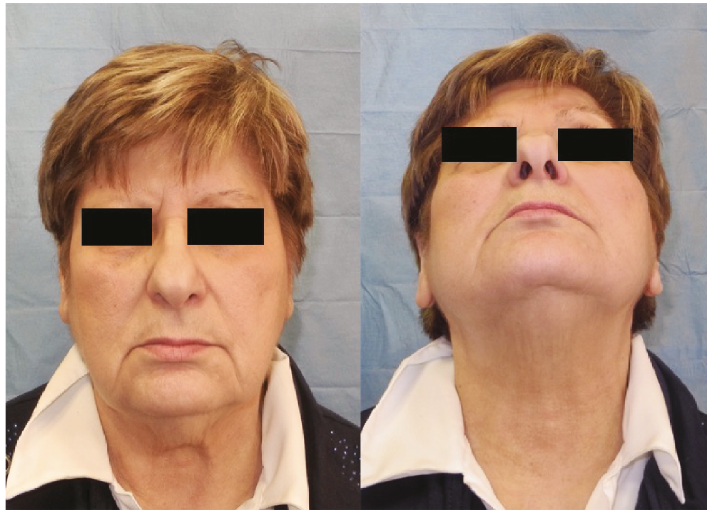
Figure 4: Clinical view 1 year after